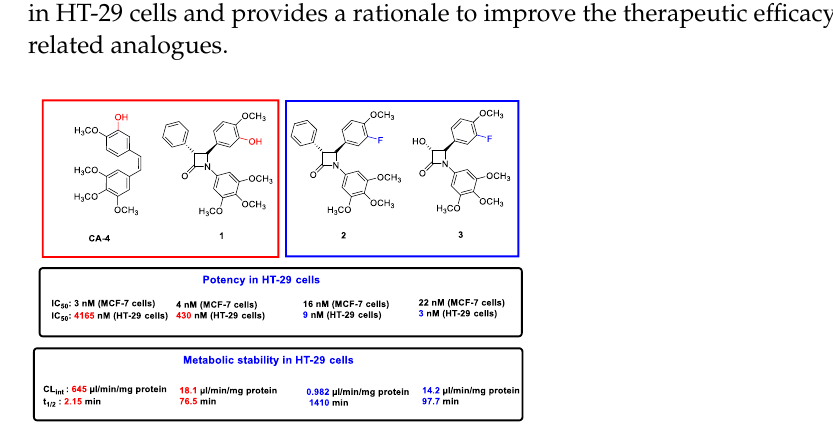
Figure 34. Metabolic stability in HT-29 cells of CA-4 and its representative β-lactam analogues. 4.32. Using Metabolic Glycoengineering for Targeted Treatment of Cancer (P32)